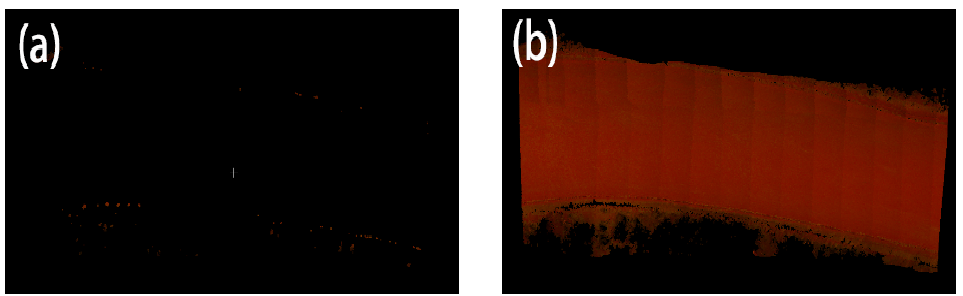
Figure 24. The segmentation results of the datasets of Figure 16b with CSF : ( a ) is the removed points; ( b ) is the remaining points.